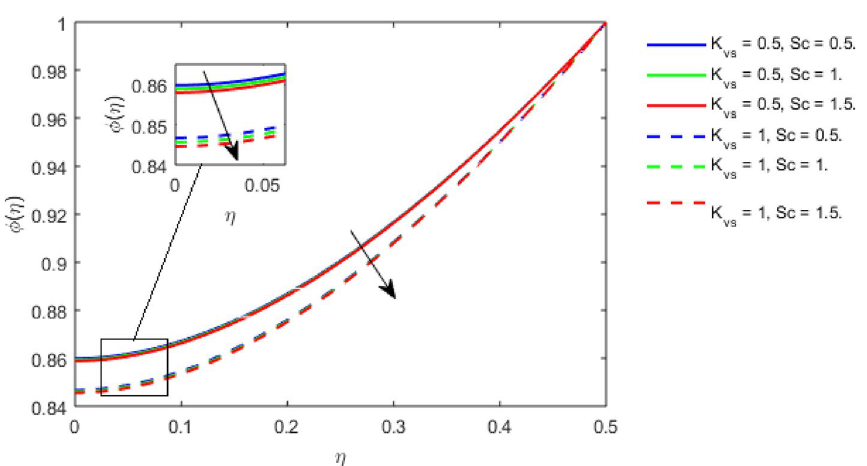
Figure 16. Concentration profile for increasing Sc , K vs , for Dilatant fluid by keeping thickness index m = 0.8 .